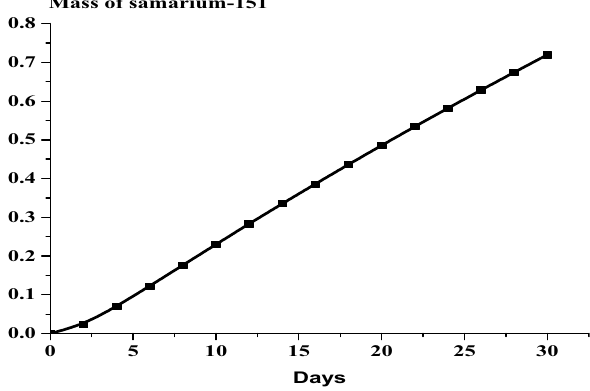
Figure 16. Grams of Sm-151 in the F-lattice over 30 days with 1 day time steps.